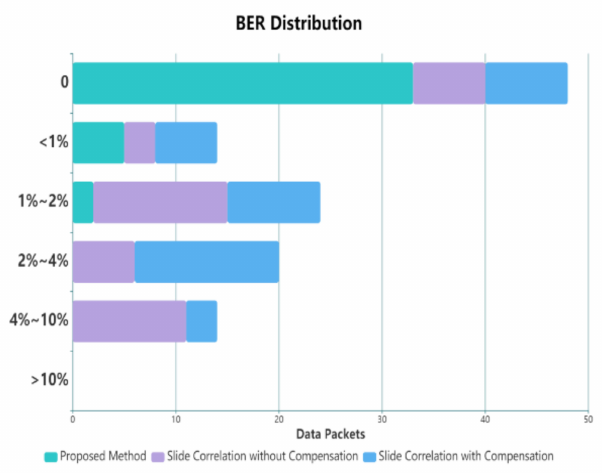
Figure 16. BER performance of three